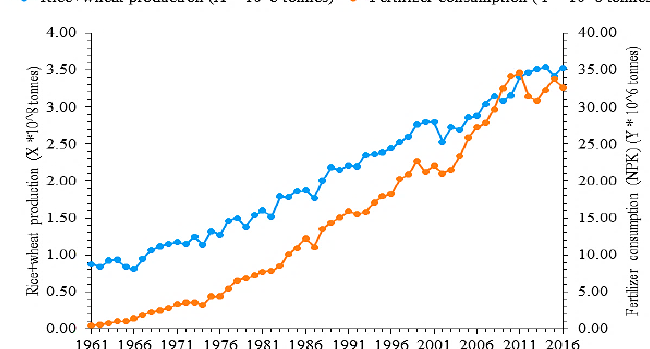
Figure 1. Trends of rice + wheat production and fertilizer consumption during the period 1961–2016 on the Indian subcontinent, Reproduced with permission from FAO (http://faostat.fao.org/).